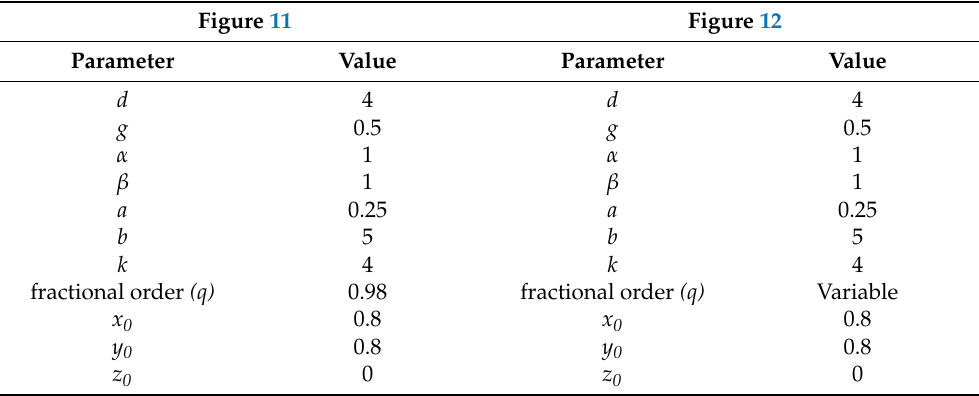
Table 2. The system (14) parameters used in plots of Figures 11 and